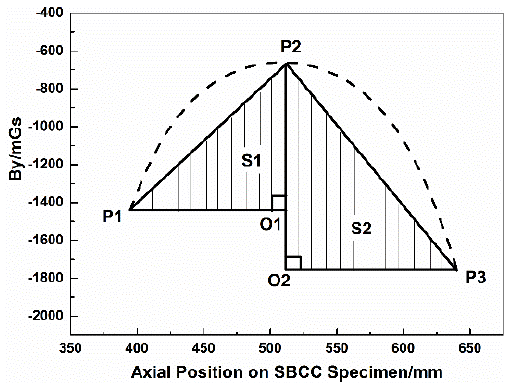
Figure 10. Schematic diagram of the values of the area ratio deviation parameter S D .